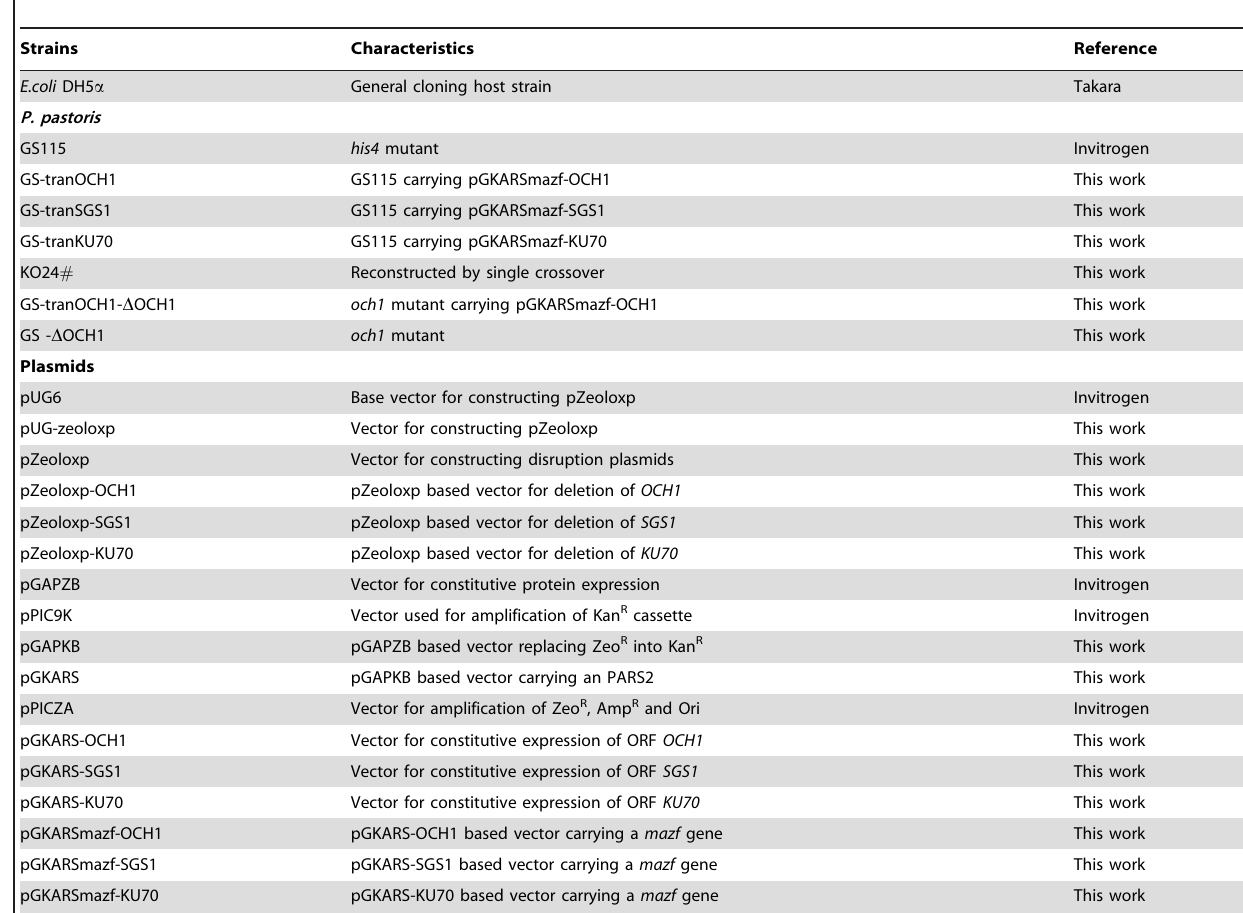
Table 1. Strains and plasmids used in this work.